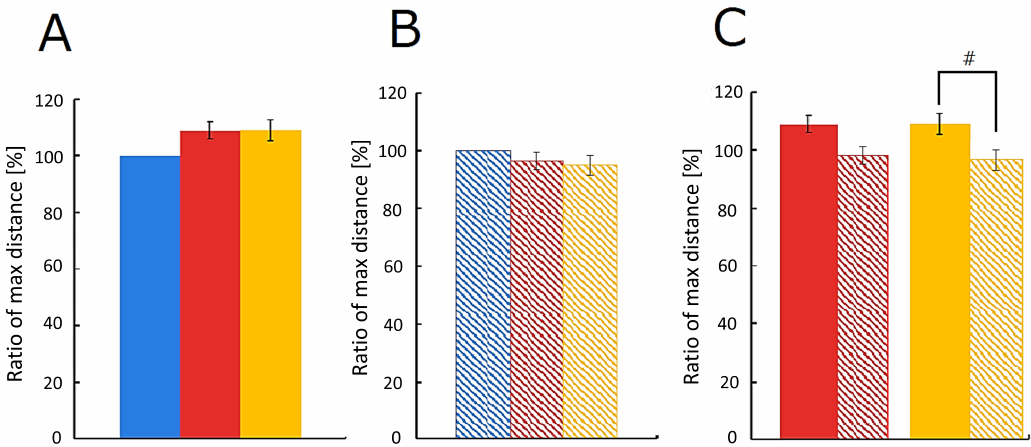
Fig. 7. Comparison of maximum distance. The lesion-induced changes are shown as percentages of the value before the lesion (blue bar). The maximum distance between the first and fifth fingertips in the lesioned rats (A) is compared before (blue column), 6th days after (red column), and 15th days after (yellow column) the cortical lesion. The data from sham-operated rats are shown in B. The maximum distance of each exhibits a small decrease with no statistical significance. A comparison between the lesioned rats and sham-operated rats (C) showed that sham-operated rats were significantly smaller 15th days after (Student’s t -test, # p < 0.05). Data are represented as mean ±